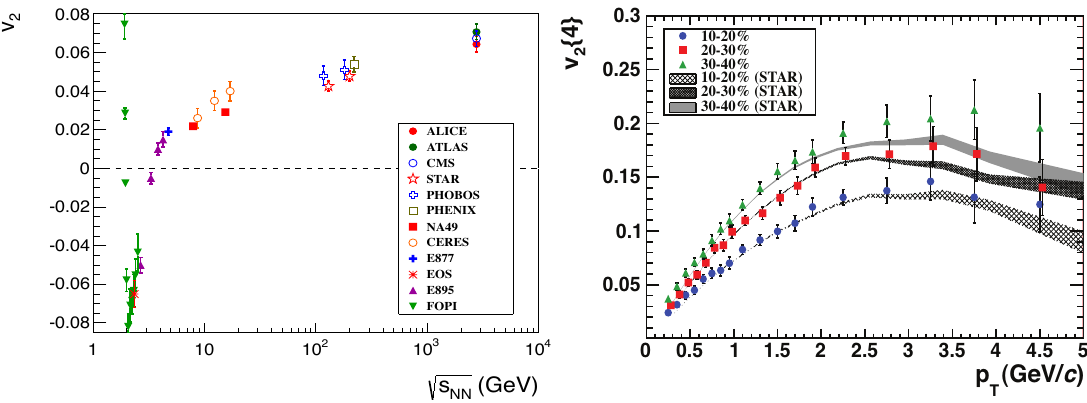
Figure 19. Left : A compilation of data on the dependence of the integrated elliptic flow, v 2 , on the beam energy. The data correspond to ( ∼ 20%–30%) Au + Au or Pb + Pb most central collisions. Reproduced from Ref. [193]; Right : The differential elliptic flow of charged particles. The Pb + Pb collisions at √ s = 2.76 TeV (colored symbols) are compared to Au + Au collisions at NN Reproduced from Ref.